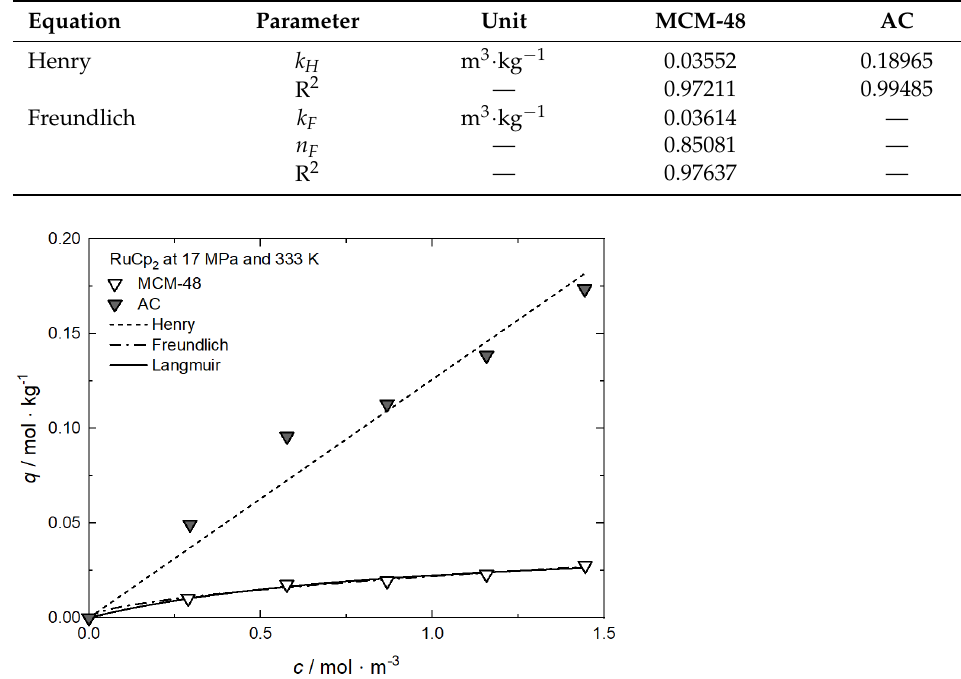
Figure A15. Uptake of RuCp 2 at 17 MPa and 333 K on different substrates; experimental data taken from [64]. Table A15. Adsorption isotherm parameters for RuCp 2 from scCO 2 solution at 17 MPa and 333 K on different substrates [64].